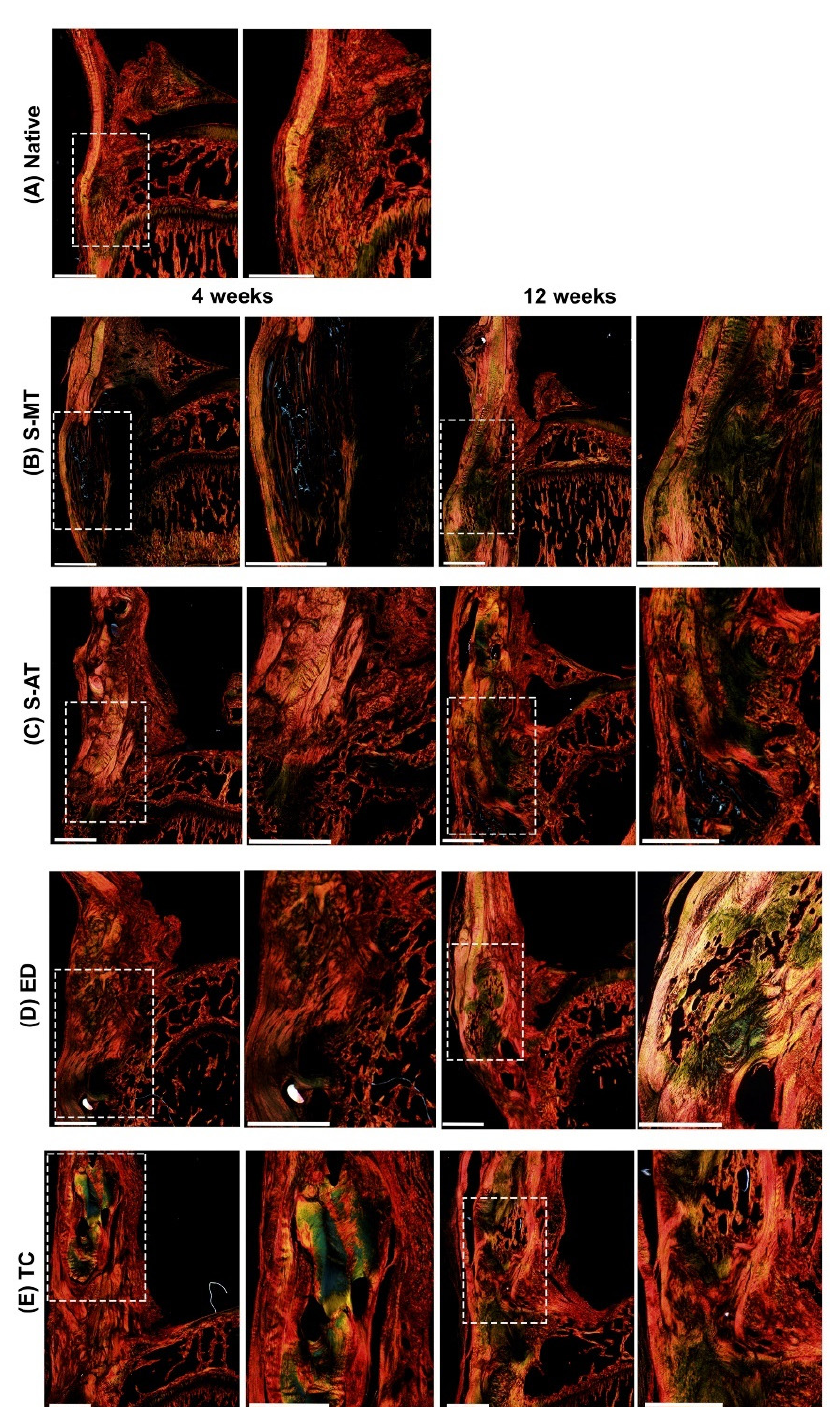
Figure 7. Picrosirius red staining. Representative images of the histological analysis of enthesis defects at the patellar region at 4 (left pairs) and 12 weeks (right pairs) after surgery, in ( A ) native enthesis, ( B ) S-MT with mixed transition, ( C ) S-AT with abrupt transition, ( D ) empty defect, and ( E ) transversal cut at enthesis site. Dashed squares in the left pairs indicate the locations of the zoomed-in areas shown on the respective right. Scale bars = 800 µm.